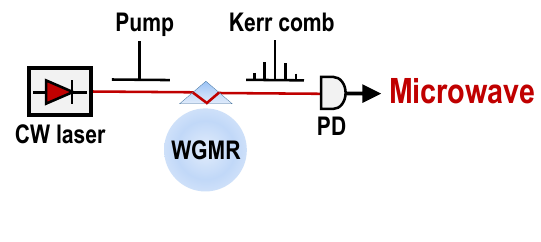
Figure 7: Simplified experimental set-up for microwave generation using Kerr combs. CW, continuous wave; PD, photodetector.